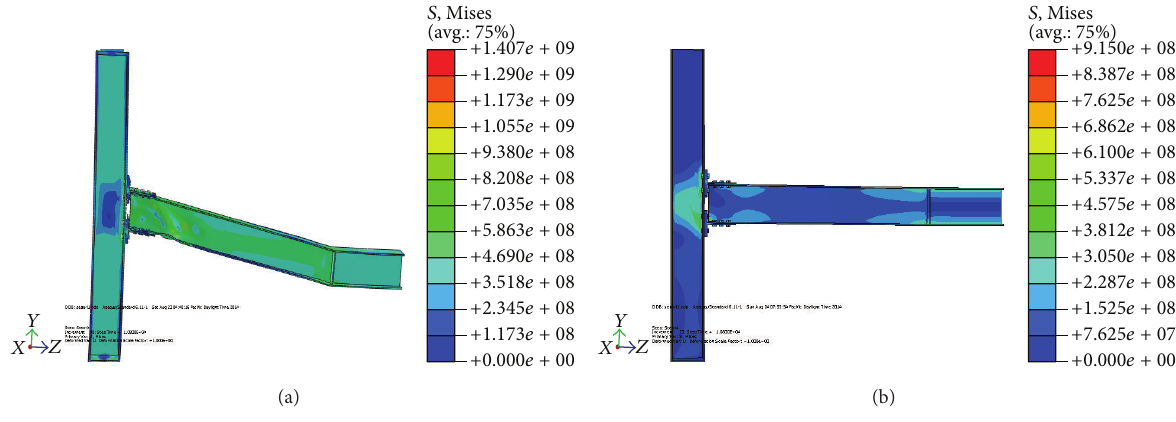
Figure 12: T joint: (a) with heat and (b) without